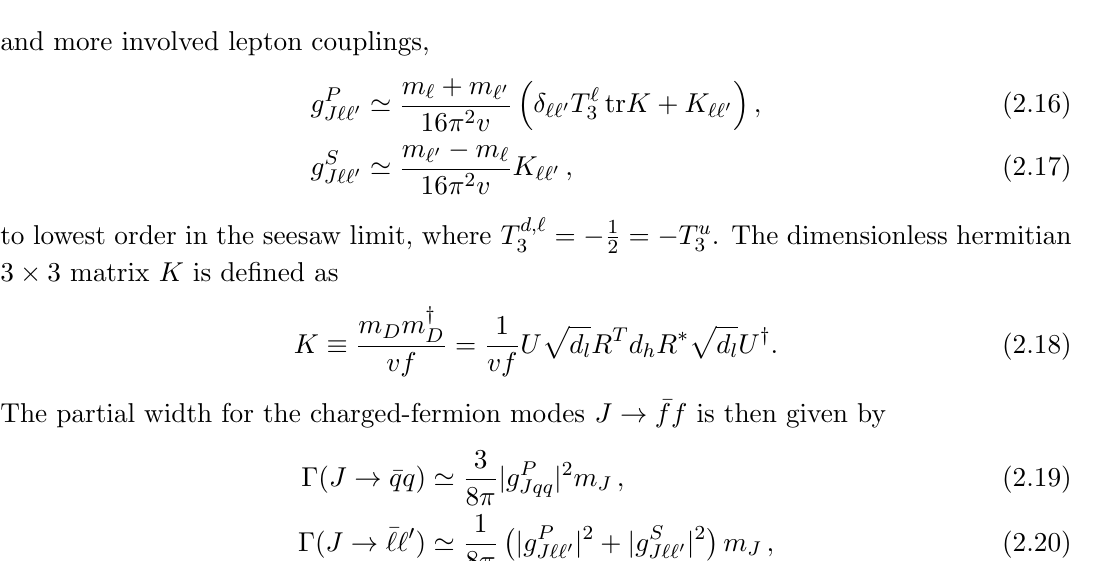
Figure 1 . Loop-induced majoron couplings to charged fermions with the Majorana neutrino mass eigenstates n i running in the